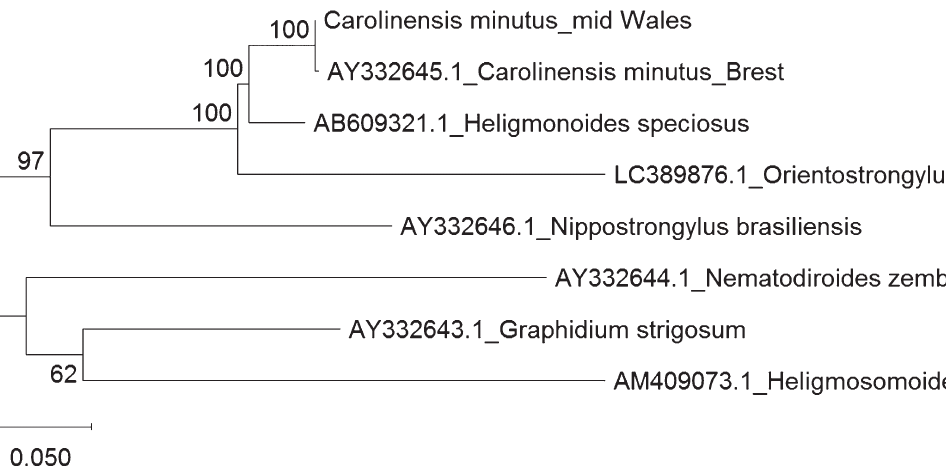
Figure 2. Maximum likelihood phylogenetic tree for concatenated Internally Transcribed Spacer (ITS) 1 and ITS2 sequences in Carolinensis minutus in mid Wales and Brest, France and in other representative heligmosomoids. GenBank accession numbers for ITS1 precede the taxon names. The tree with the highest log likelihood is shown, based on 493 positions. Percentage bootstrap support is shown for taxon clusters; branch lengths represent substitutions per site (scale bottom